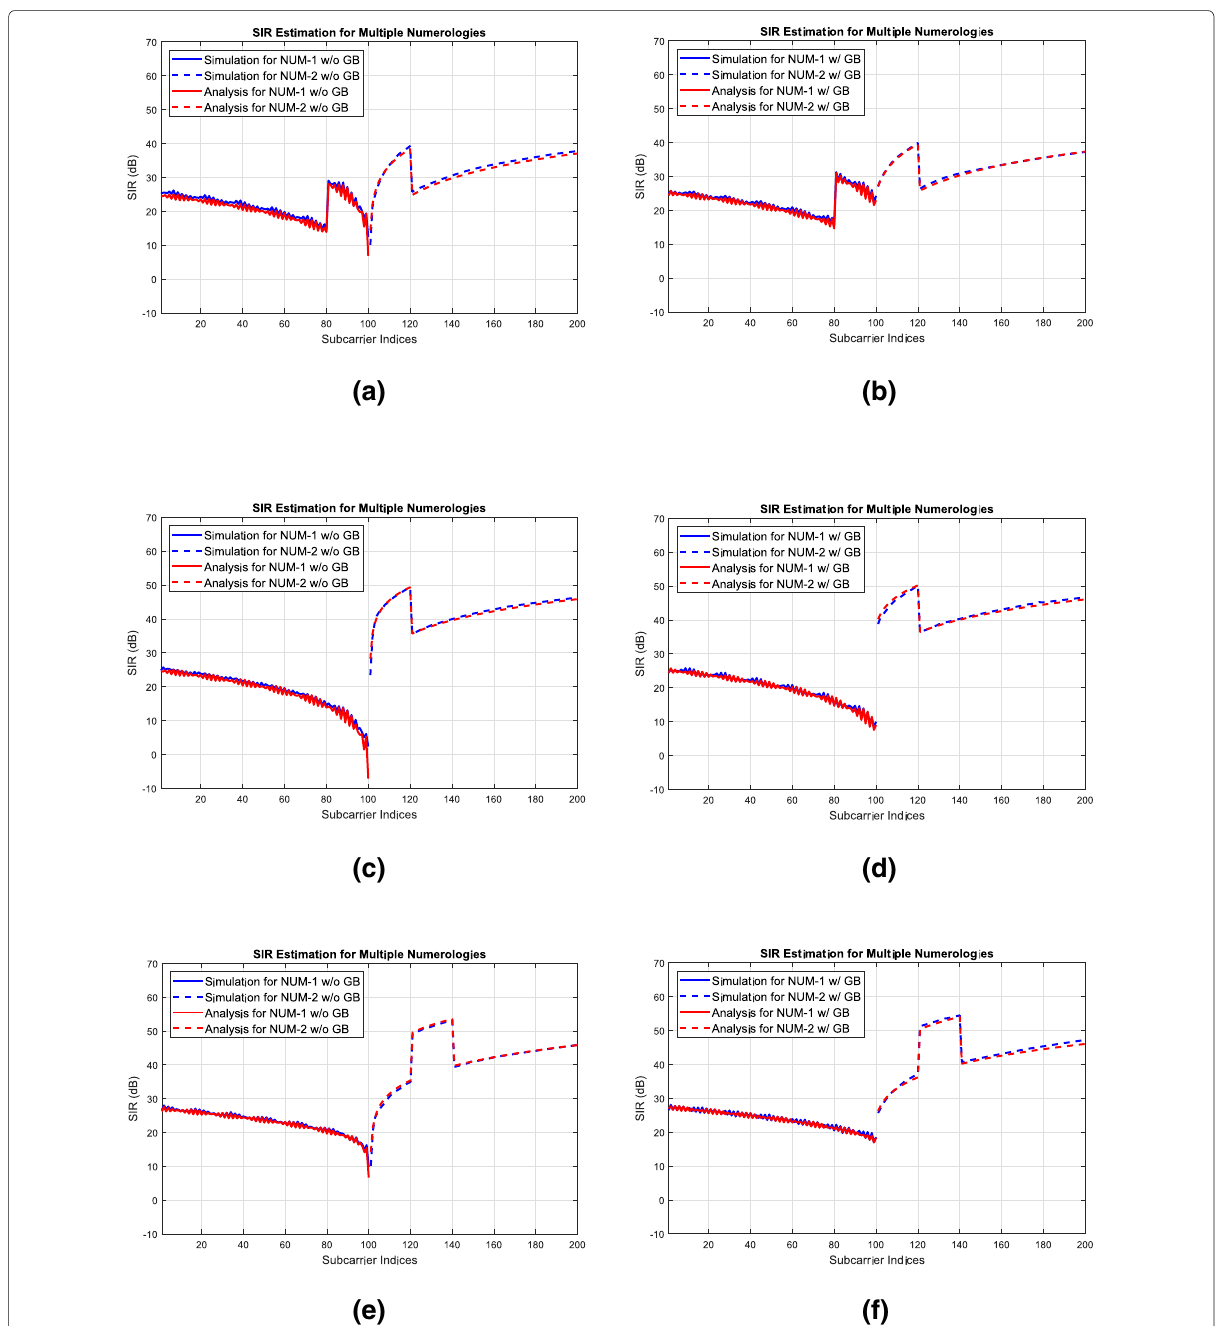
Fig. 8 Performance analysis results for different cases. NUM-1 has a narrow SCs with 15 kHz (cid:2) f , and NUM-2 has a wide SCs with 30 kHz (cid:2) f . If there is a PO, it is 7 dB. There are five UEs for NUM-1 and five UEs for NUM-2 with equal number of SCs. a Case 1: edge UEs of NUM-1 and NUM-2 have higher PLs than the other UEs. There is not any POs between the edge UEs. There is not any GB between numerologies. b Case 2: edge UEs of NUM-1 and NUM-2 have higher PLs than the other UEs. There is not any POs between the edge UEs. There is a GB of six SCs between numerologies. c Case 3: edge UE of NUM-2 has a higher PL than the other UEs. There is not any GB between numerologies. d Case 4: edge UE of NUM-2 has a higher PL than the other UEs. There is a GB of six SCs between numerologies. e Case 5: non-edge UE of NUM-2 has a higher PL than the other UEs. There is not any GB between numerologies. f Case 6: non-edge UE of NUM-2 has a higher PL than the other UEs. There is a GB of six SCs between